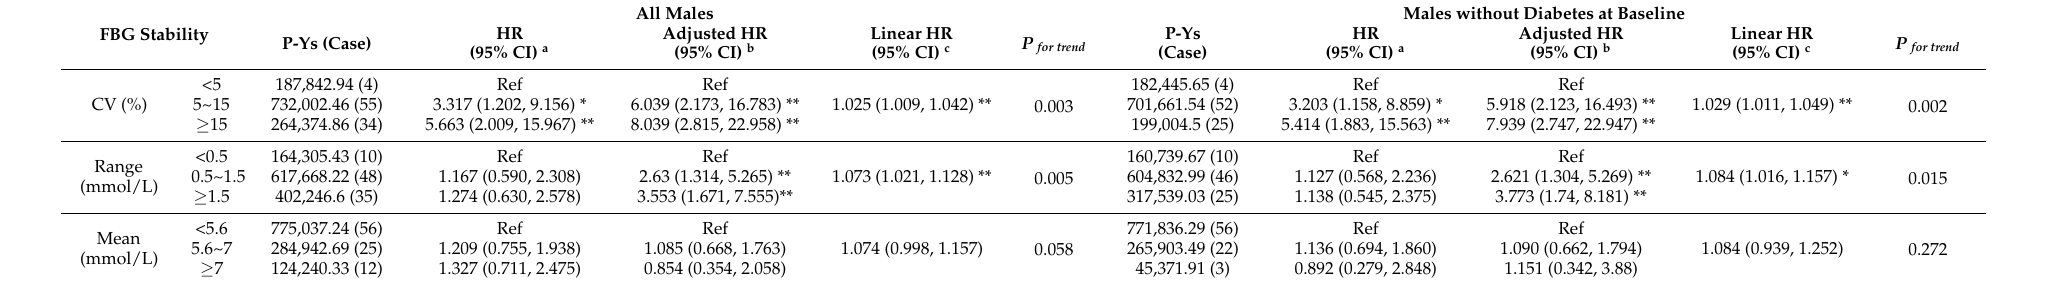
Table 3. Hazard ratios (HRs) for the association between CV of FBGs and pancreatic cancer risk. FBG